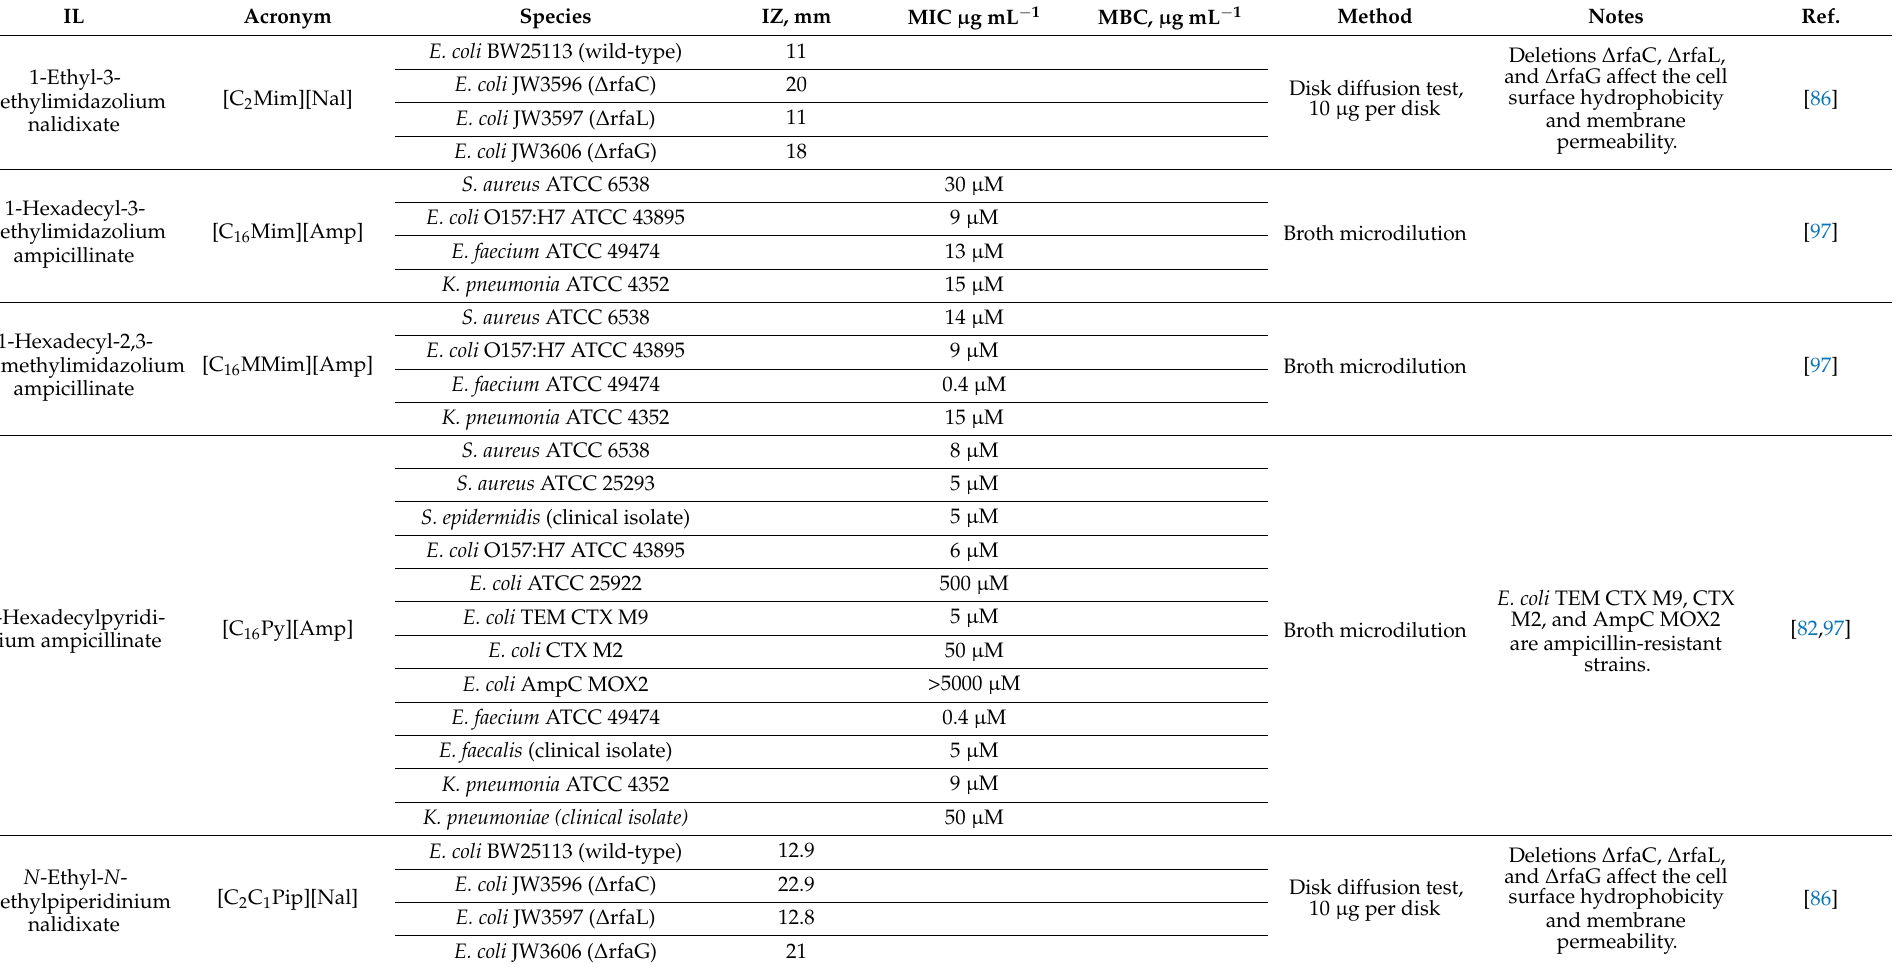
Table 3. Antimicrobial activity of API-ILs